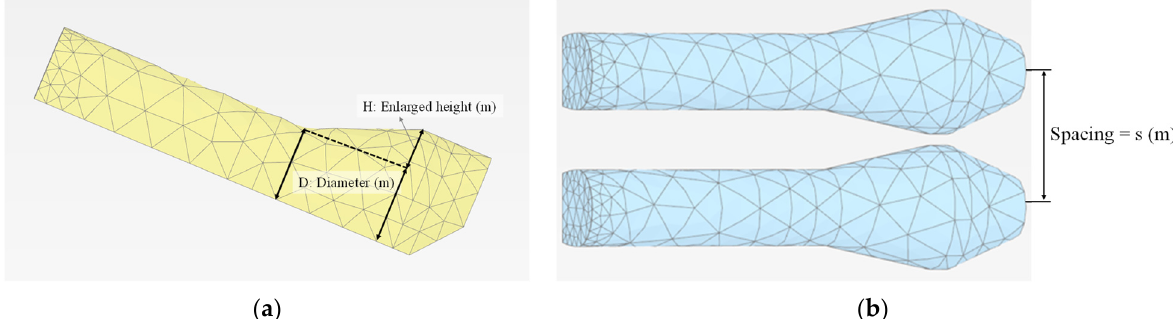
Figure 5. Enlarged height and spacing of the tunnel-type anchorage: ( a ) enlarged height and ( b ) spacing. Table 3. Summary of the numerical analyses conducted.